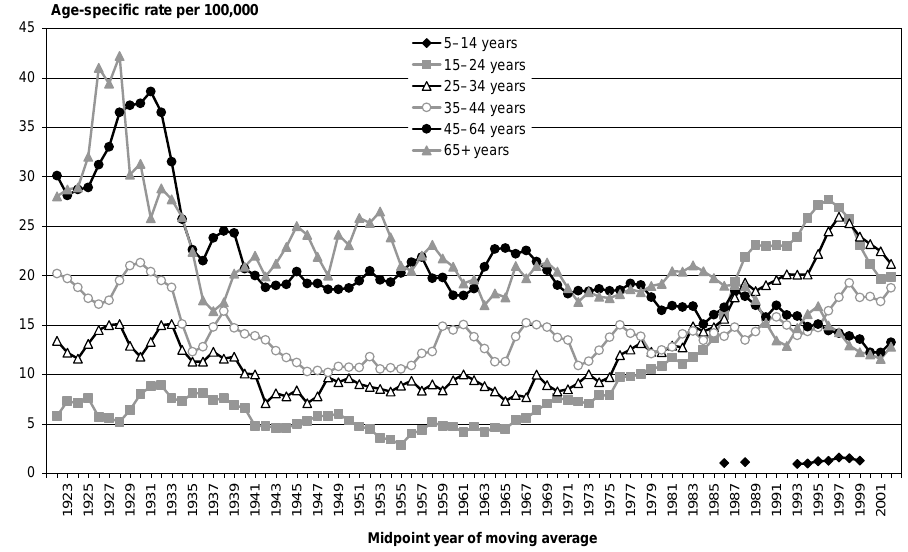
FIGURE 4. Suicide death rates, by age, 3-year moving averages, 1921–2003. Source : New Zealand Health Information Service[34].